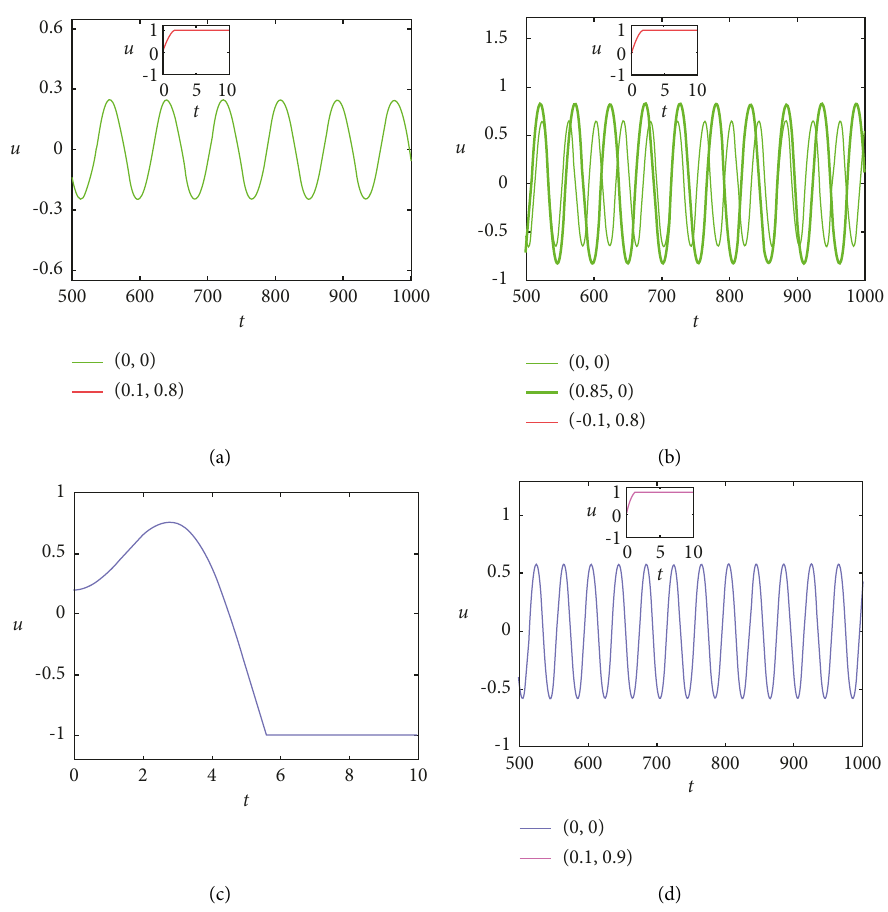
Figure 7: Time histories of system (2) under different values of α and ω . (a) α � 0 . 3, ω � 0 . 35. (b) α � 0 . 3, ω � 0 . 7. (c) α � 0 . 7, ω � 0 . 35. (d) α � 0 . 7, ω � 0 .